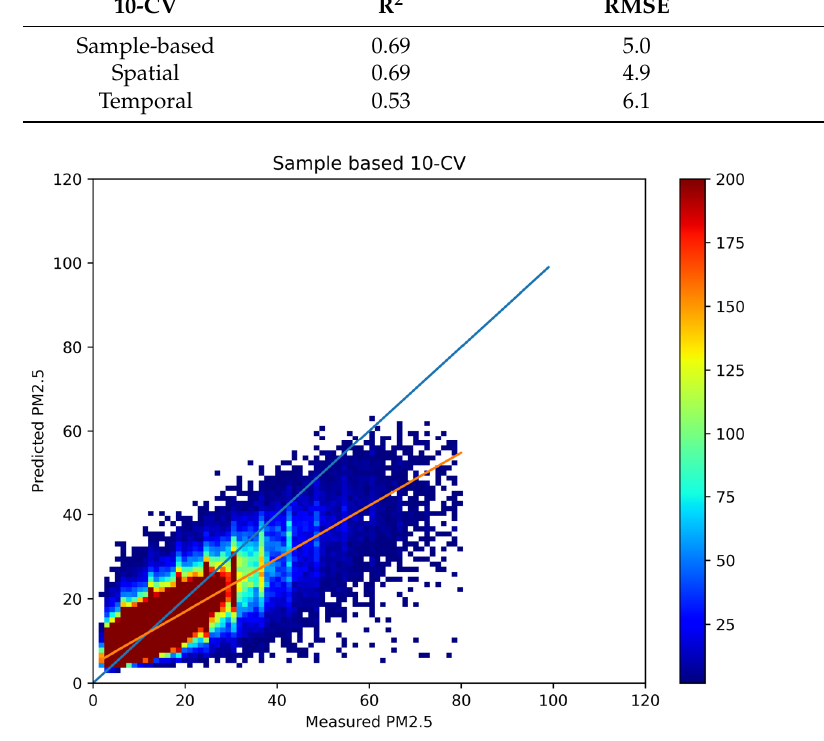
Figure 3. Density scatter plot of the sample-based 10-CV results of the model.